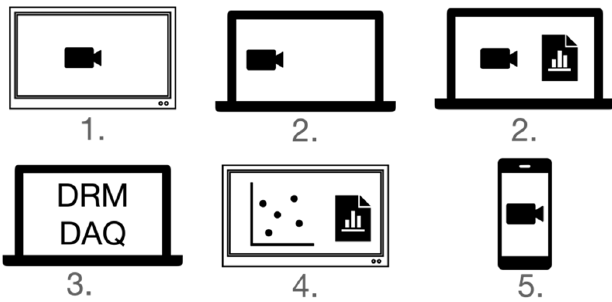
Figure 5 1. TV with dome/reactor camera, 2. Video conferencing/Spreadsheet laptops 3. Digital acquisiton/Digital Reactivity Meter laptop, 4. Common digital whiteboard, 5. Portable remote